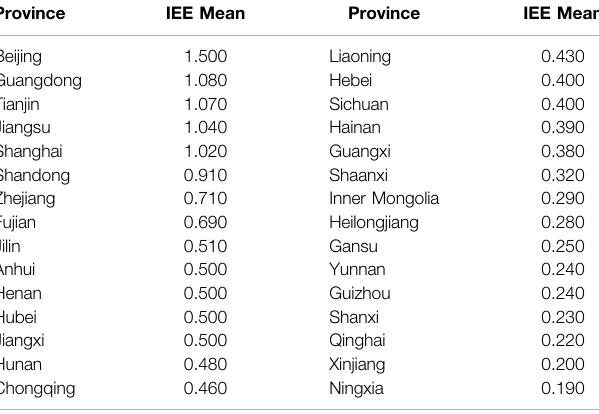
TABLE 3 | Regional IEE from 2009 to